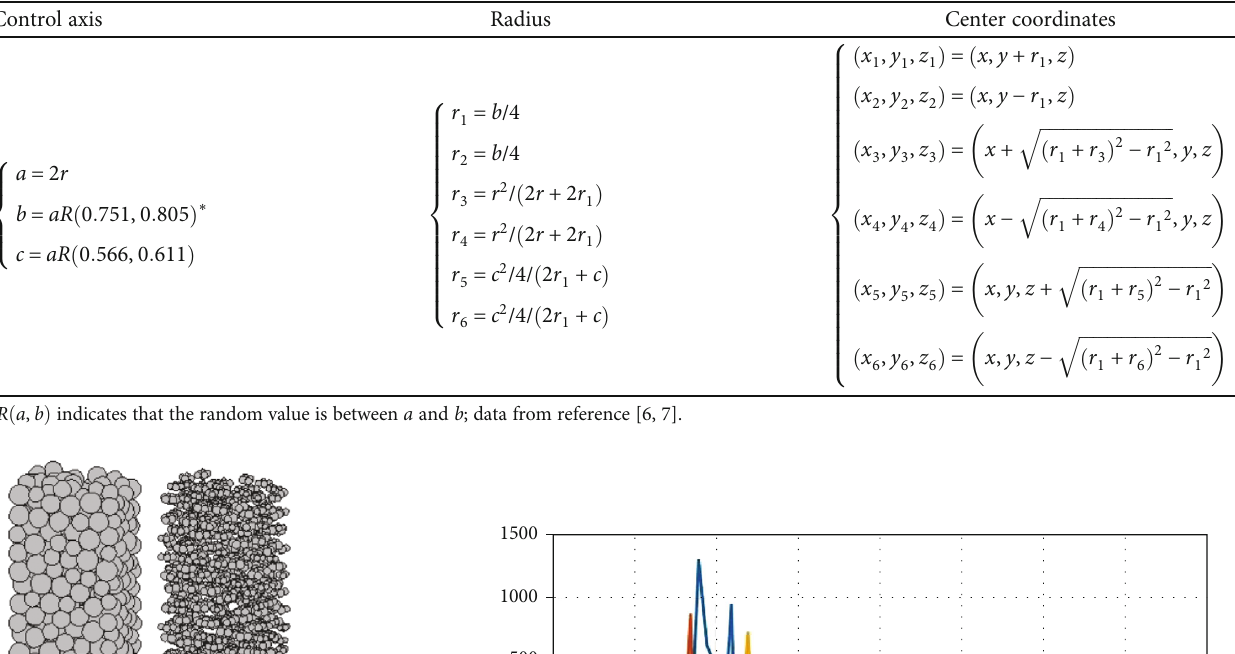
Table 1: Calculation of radius and center coordinates for each element.